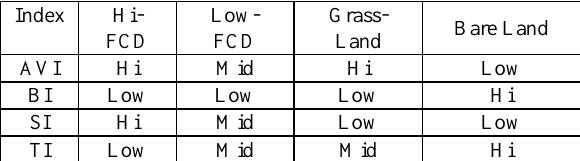
Table 1: Combination Characteristics between Four